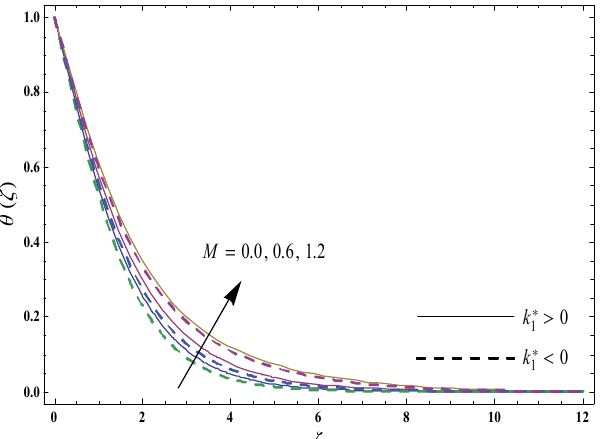
0  1 and  = Pr = 1  0  Fig. 2 : Variations of temperature for magnetic parameter when  Figure 2. Variations of temperature for magnetic parameter when N b = 0.2, N t = 0.1 and Sc = Pr = 1.0.